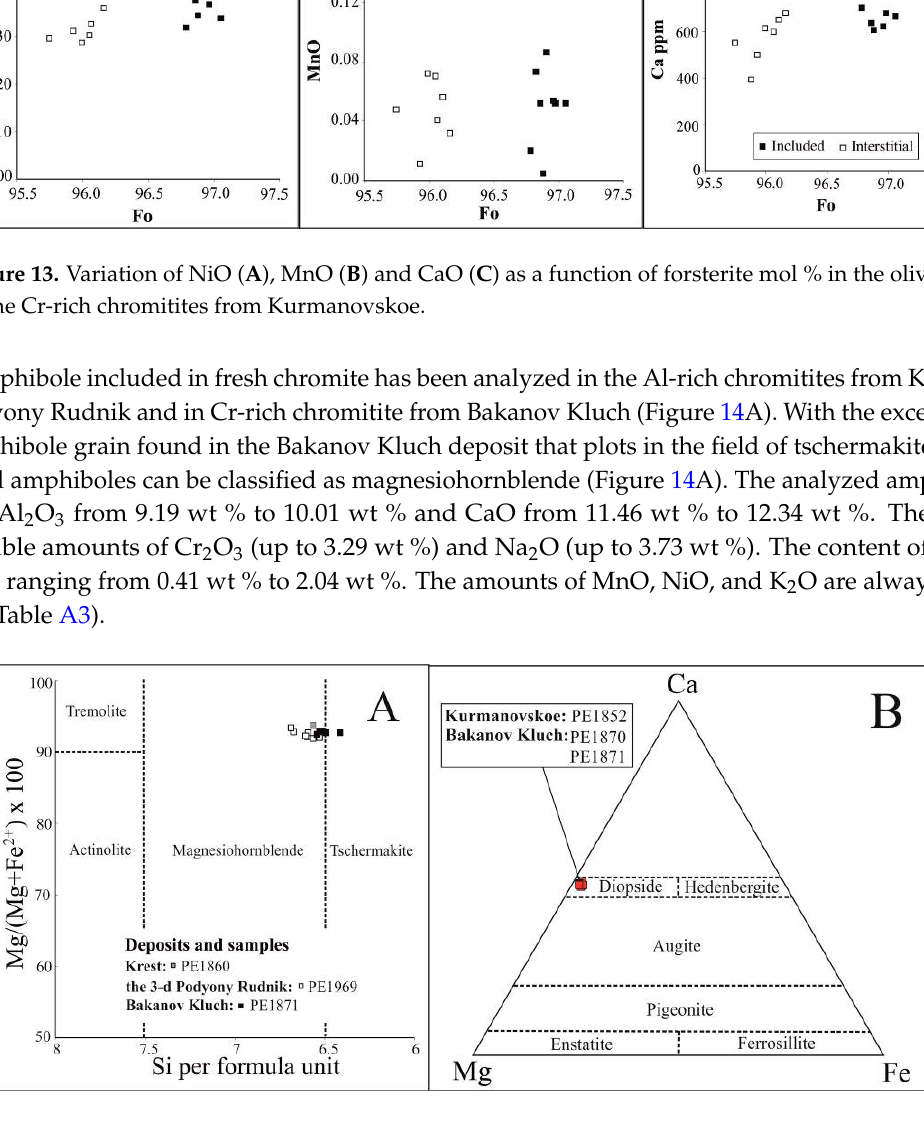
Figure 13. Variation of NiO ( A ), MnO ( B ) and CaO ( C ) as a function of forsterite mol % in the olivine in the Cr-rich chromitites from Kurmanovskoe.